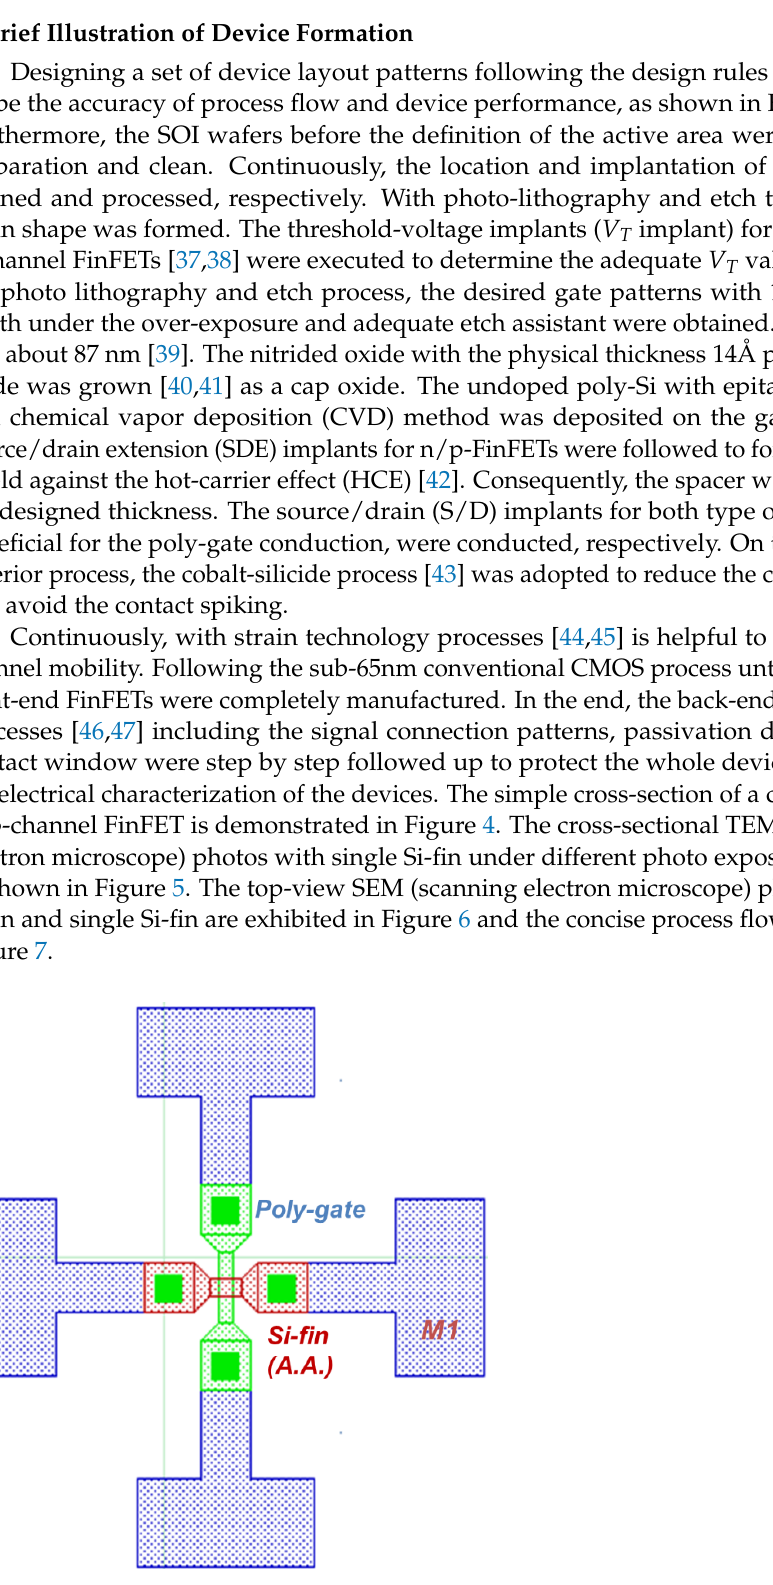
Figure 2. The top-view layout for single FinFET.